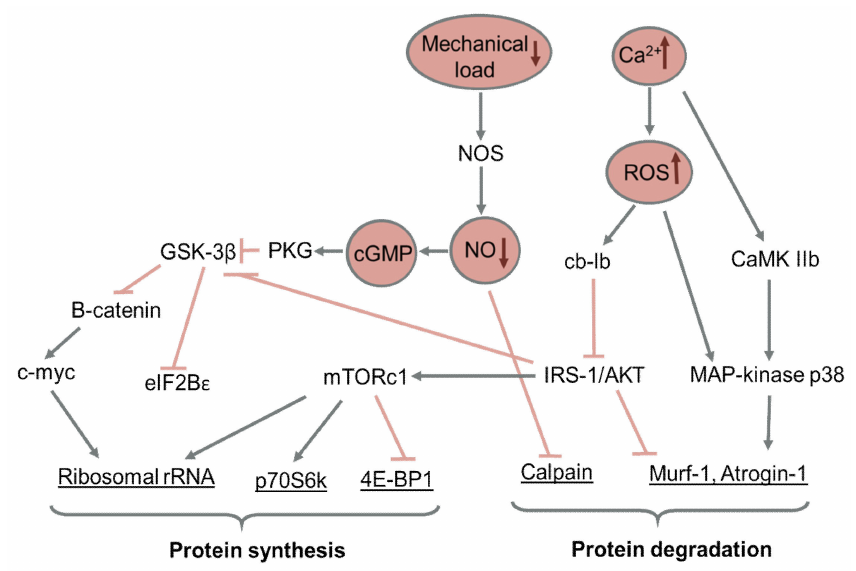
Figure 2. Key signaling pathways regulating protein turnover during muscle disuse. Pointed arrows show activation; blocked arrows show